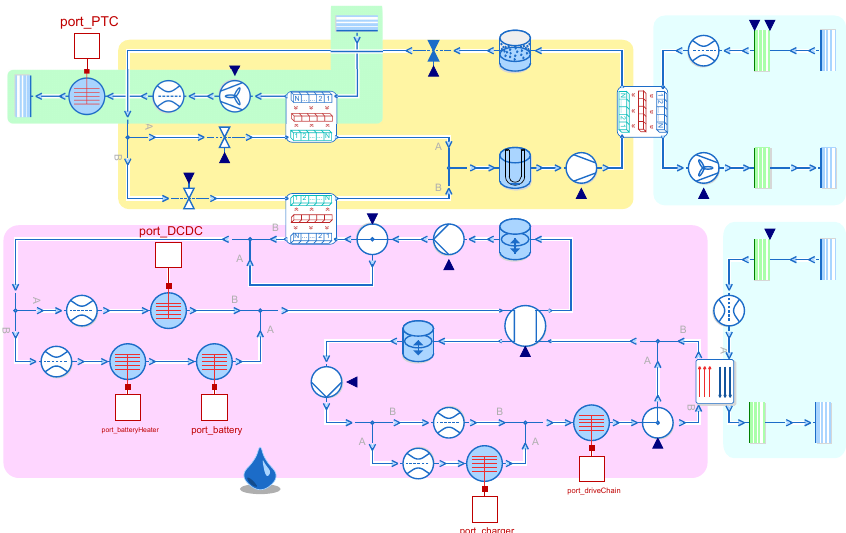
Figure 1. Example simulation of an automotive battery, drive-chain and cabin thermal control system. The glycol-water loop (magenta) is cooling battery, DC–DC converter, charger, and drive-chain. A four-way switch can split it into two separate loops instead of the combined loop that is shown. If needed, the loop is cooled by a radiator against fresh air (blue). Additionally it can be cooled with a R134a vapor-cycle (orange). The vapor-cycle is also cooling air going to the vehicle cabin (green) and, therefore, contains two parallel evaporators, that can independently be shut off by two valves when not in use. It is cooled against fresh air with a condenser. Furthermore, it contains receiver, accumulator, and an expansion valve. Battery and cabin-air can be heated with the battery heater and PTC, respectively. Both heat exchangers of the glycol loop can be bypassed if not in use. One of the fresh-air streams and the cabin-air stream is supported by a fan, while the other fresh-air stream is driven purely by dynamic pressure from the vehicle speed. See Figure 2 for a detailed shape explanation.